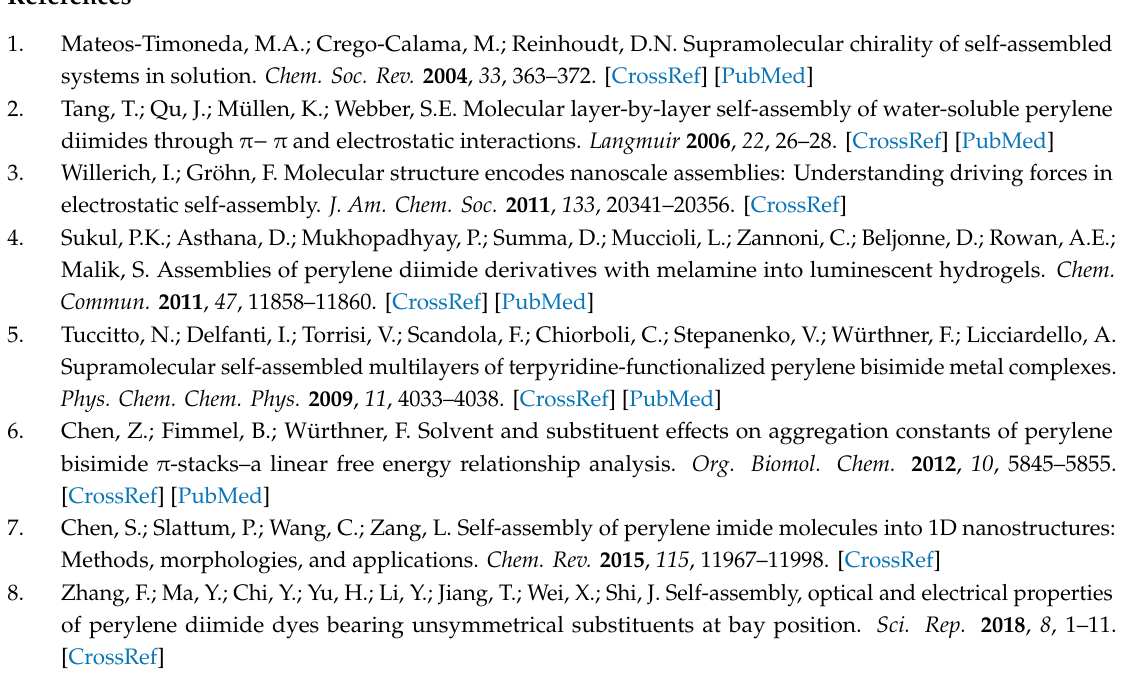
Figure S1: 1H NMR spectrum of PBI-1 in CDCl3, Figure S2: 13C NMR spectrum of PBI-1 in CDCl3, Figure S3: FT-IR spectrum of PBI-1, Figure S4: 1H NMR spectrum of PBI-2 in CDCl3, Figure S5: 13C NMR spectrum of PBI-2 in CDCl3, Figure S6: FT-IR spectrum of PBI-2, Figure S7: Optical microscope images of PBI-1 aggregates at di ff erent r assembled in various organic acids, Figure S8: Normalized UV-vis absorption spectra of PBI-1 aggregates after 2 h heating. ( a ) r = 50:1 oxalic acid, ( b ) r = 300:1 formic acid, ( c ) r = 500:1 acetic acid, Figure S9: Digital image of PBI-1 aggregates assembled in adipic acid, r = 500:1, Table S1: Organic acid concentrations correspond to di ff erent r parameters, Table S2: The value of A 0-0 / A 0-1 of PBI-1 aggregates at di ff erent r assembled in various organic